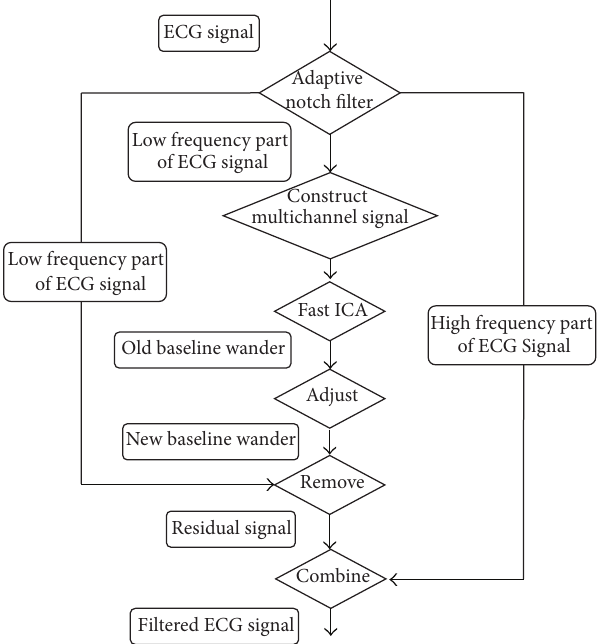
Figure 1: Schematic diagram of proposed